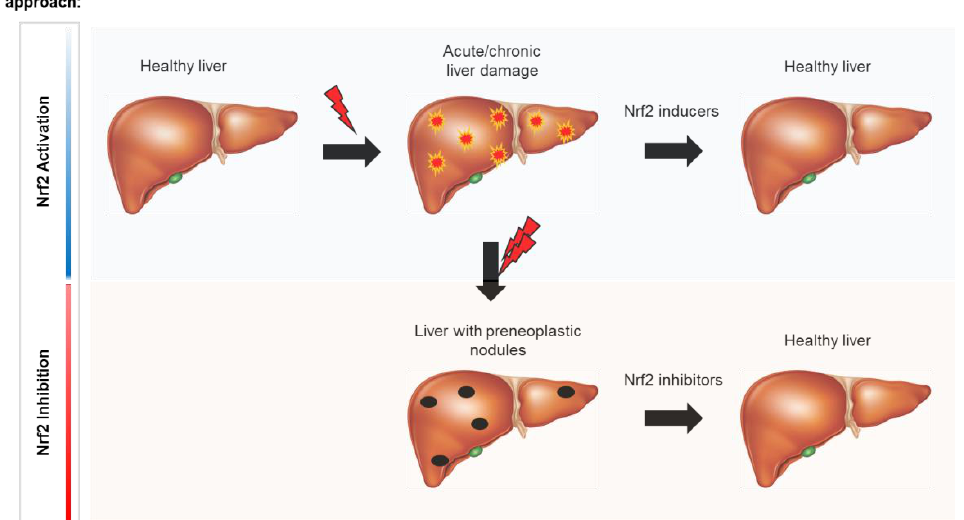
Figure 2. Schematic representation illustrating the opposite effects of Nrf2 activation on normal and carcinogen-initiated hepatocytes. Nrf2 inducers could lead to a more efficient repair of liver injury following administration of most necrogenic agents, including chemical carcinogens. On the other hand, Nrf2 inhibitors could promote reactive oxygen species (ROS)-induced injury, leading to death of preneoplastic cells, thus interfering with their progression to hepatocellular carcinoma (HCC). stress promoting stimuli.